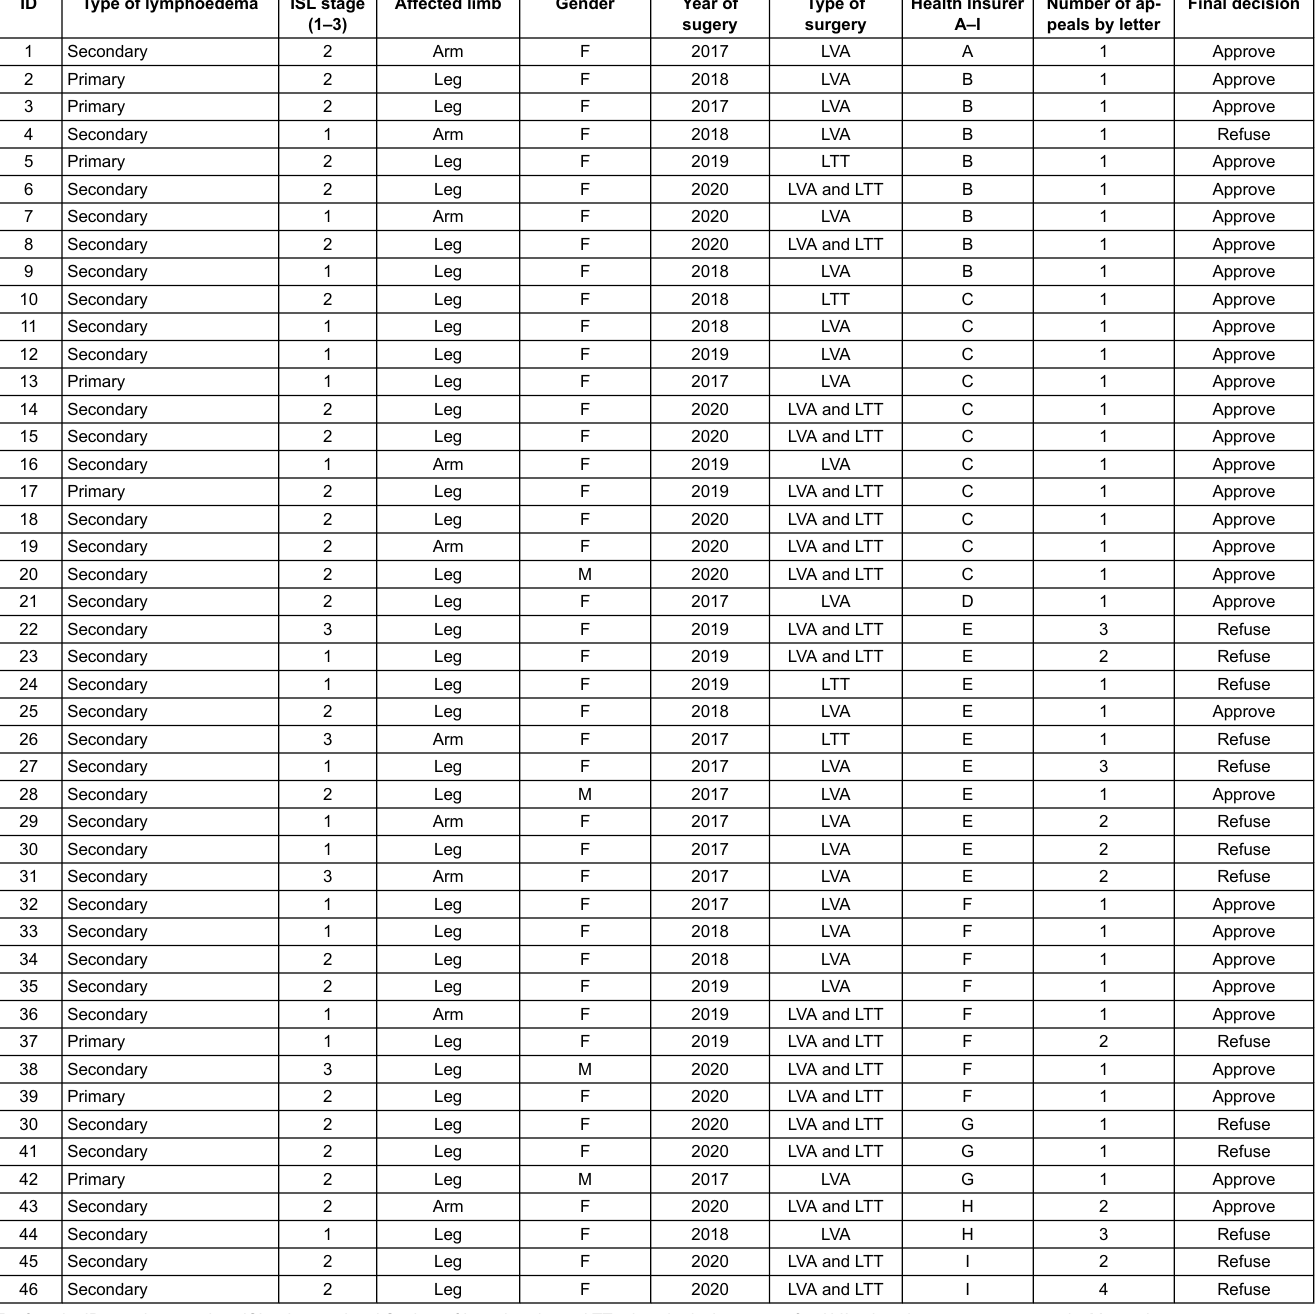
Table 1: Demographic data, insurance details and outcomes per surgical case.